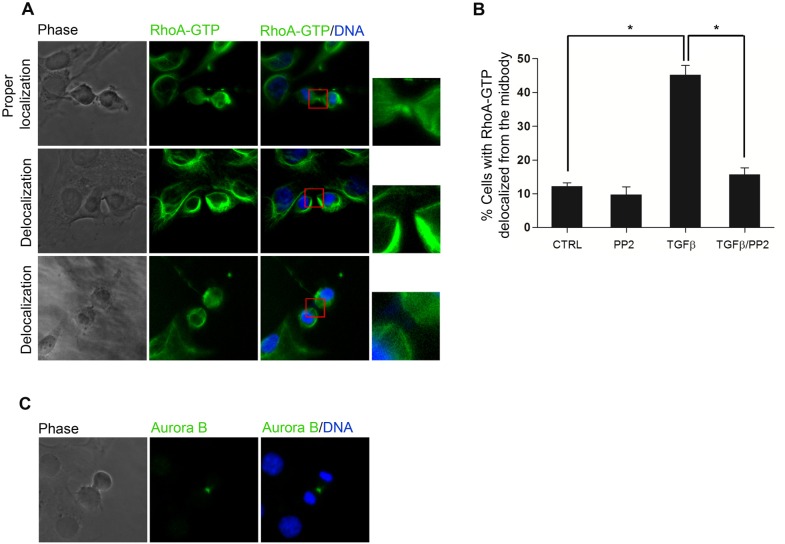
The TGFbeta1-induced cytokinesis failure is associated with the delocalization of active RhoA from the midbody.(A) Representative immunofluorescence of cytokinesis events with RhoA-GTP properly localized at the midbody (upper panel) or delocalized (middle and lower panels), considered for the count in both untreated hepatocytes and in TGFbeta-treated ones. In particular, the images refer to TGFbeta-treated hepatocytes. (B) Percentage of mitotic cells negative for RhoA-GTP signal at the midbody. Data are expressed as average values of three different experiments ± s.e.m (number of counted cells: >100 for each experimental condition) (*p value < 0.05). (C) Representative immunofluorescence of the cytokinesis events analysed in three independent experiments, showing the proper localization of Aurora B at the midbody upon TGFbeta1 treatment.